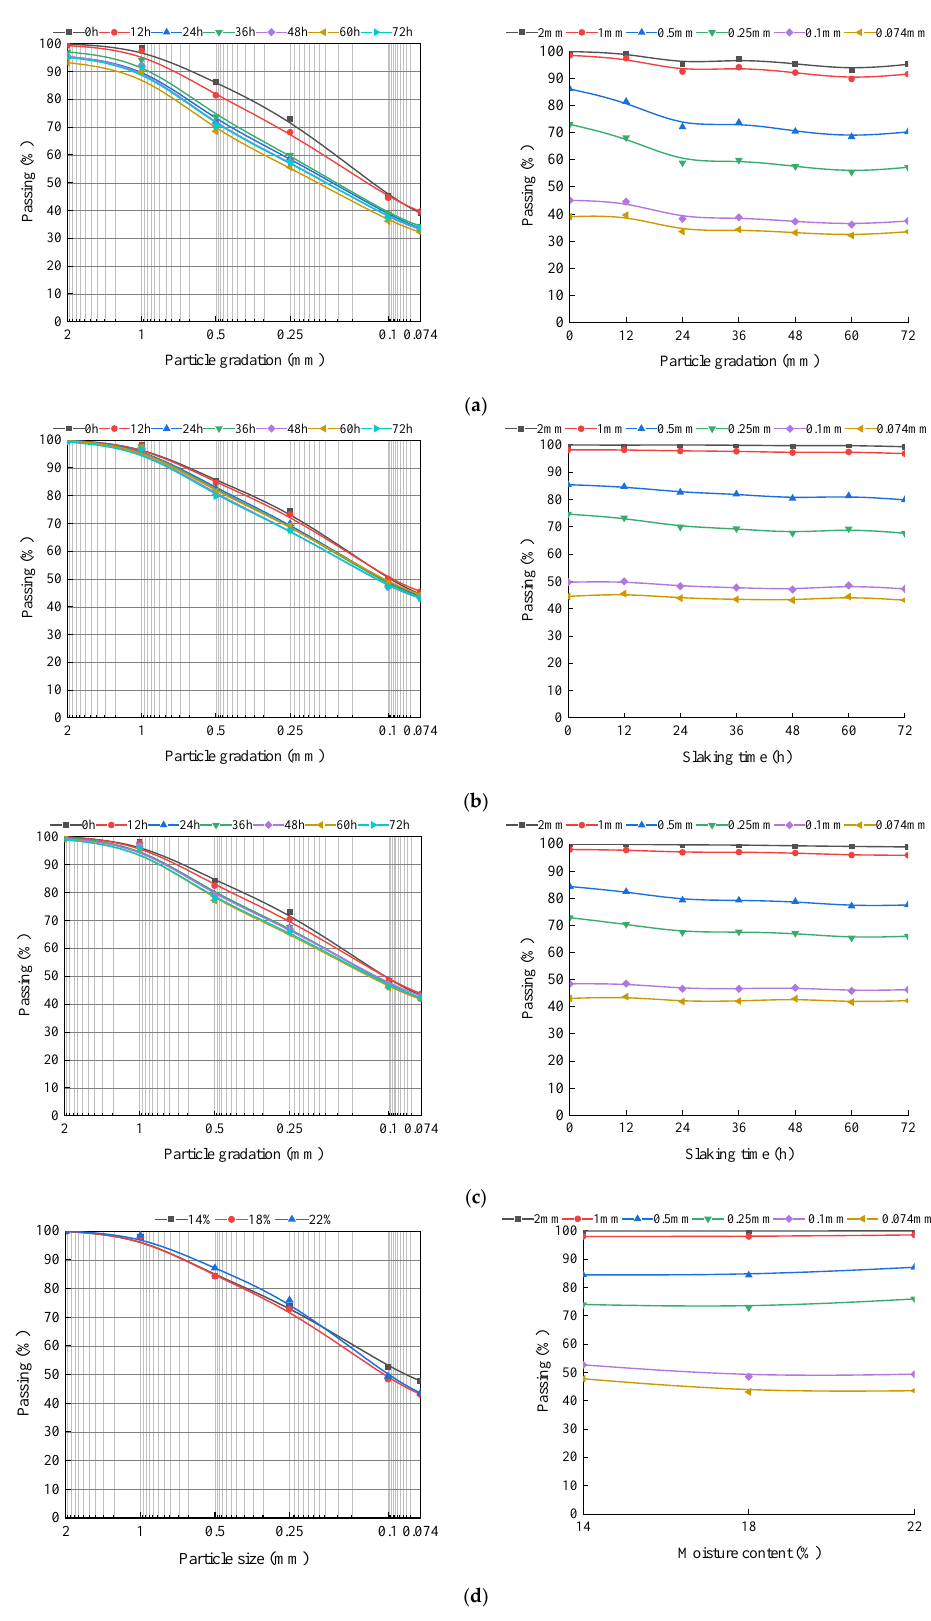
Figure 3. Particle gradation of specimens with different slaking times, lime contents and